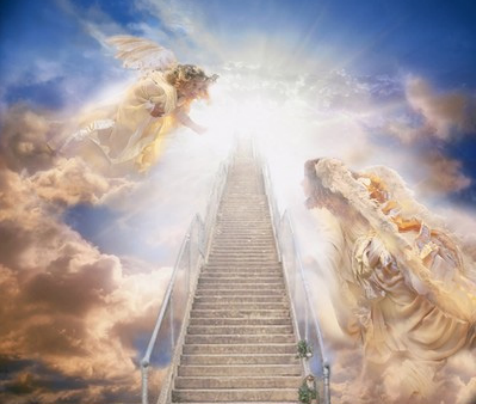
Figure 5. Angels guard the stairs that the dead climb up into heaven